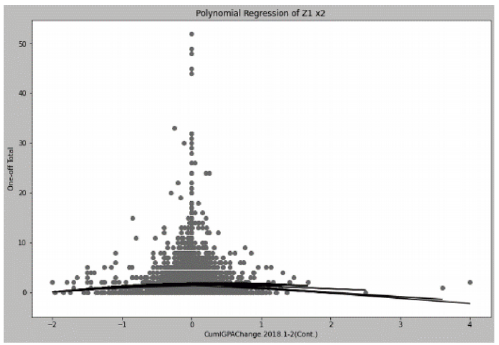
Figure 8. Polynomial Regression of Z1 x2 in Finding